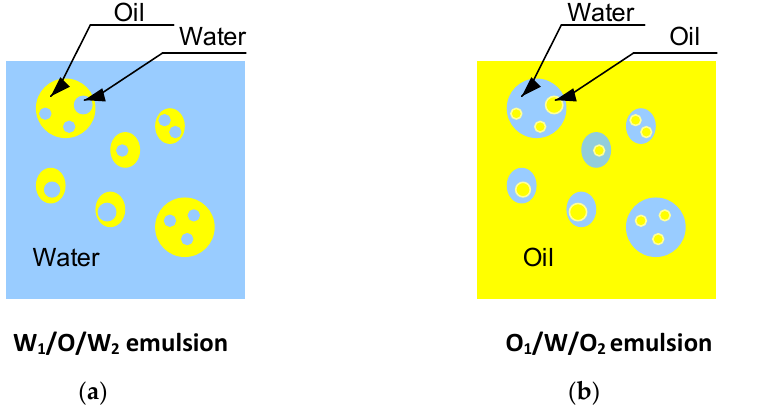
Figure A1. Structure of double emulsions: ( a ) water-in-oil-in-water emulsion (W 1 /O/W 2 ) and ( b ) oil-in-water-in-oil emulsion (O 1 /W/O 2 ). To formulate a W 1 /O/W 2 double emulsion, at least two stabilizers are introduced into the system: one lipophilic, to form the primary W 1 /O emulsion, and the second hydrophobic, to form the final multiple